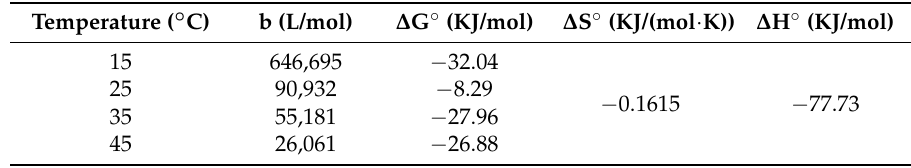
Table 3. Thermodynamic parameters for phosphate adsorption on La-chitosan magnetic spheres at 15 ◦ C, 25 ◦ C, 35 ◦ C, and 45 ◦ C,